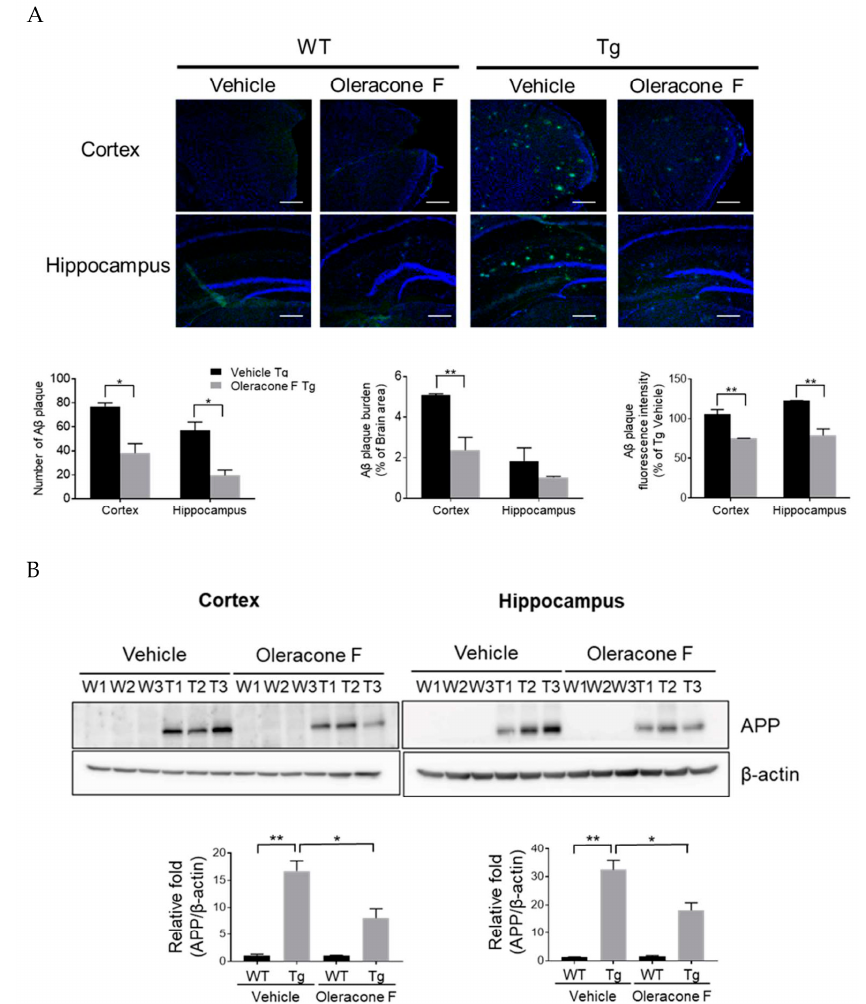
Figure 5. The treatment of AD transgenic mice with oleracone F reduced the brain A β levels. WT and Tg mice were injected with saline or oleracone F (5 μ g/kg, i.p) for 4 weeks. ( A ) To visualize the amyloid plaques, sections from mouse brains were stained with anti-A β antibody (4G8) by the immunofluorescence staining. The number of A β plaques, the area occupied by A β plaques (A β plaque burden), and the fluorescence intensity of A β plaques were analyzed with ZEN2009 software on a Zeiss LSM confocal microscope (Carl Zeiss, Jena, Germany). Scale bar, 200 μ m. ( B ) The APP protein levels were determined by Western blot analysis using 30 μ g of protein extracts obtained from the mouse cortex and hippocampus. Quatifications of the bands were performed using densitometry (ImageJ software, 1.49 v). Results were normaliozed to β -actin. Data represented are mean ± SEM (n = 3). Statistical significance are denoted ad * p < 0.05 and ** p <